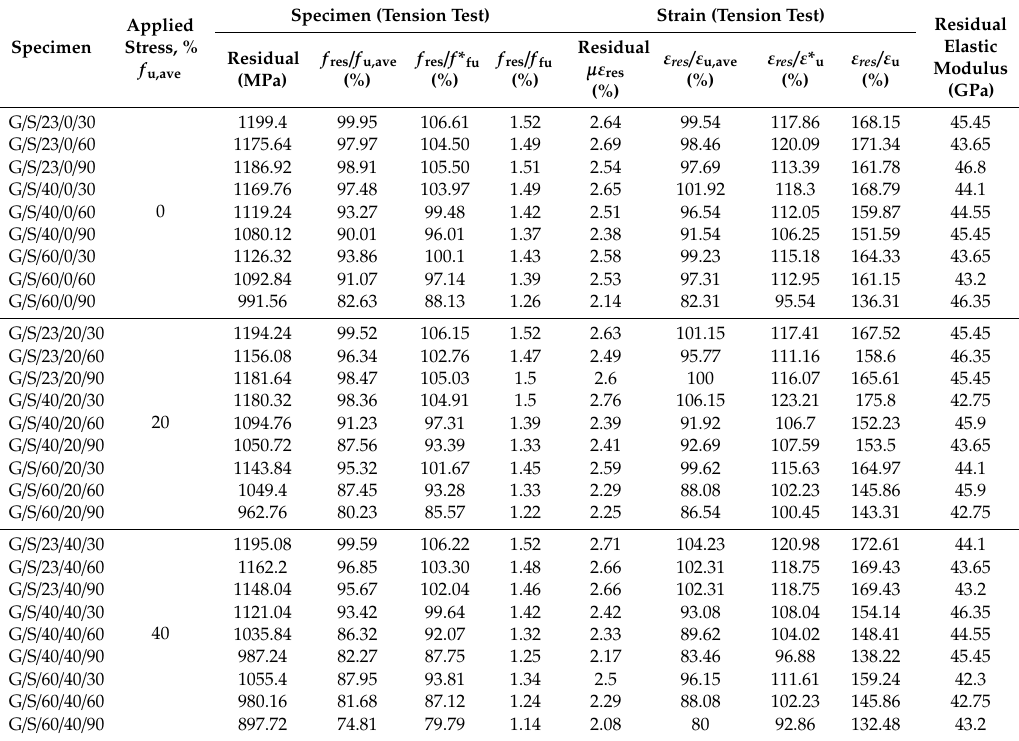
Table 4. Experimental tensile properties of conditioned GFRP specimens exposed to seawater solution.